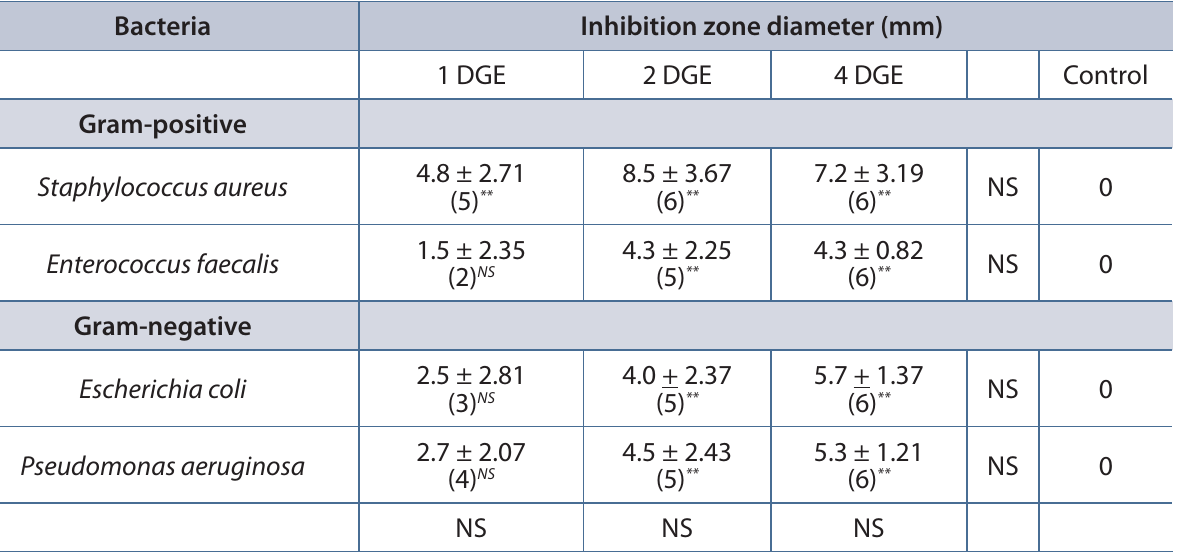
Table 1. Antibacterial activity of three concentrations of Crematogaster pygmaea crude venom. Data are reported as the mean ± SD (n = 6). The number of replicates that produced inhibition zone is indicated